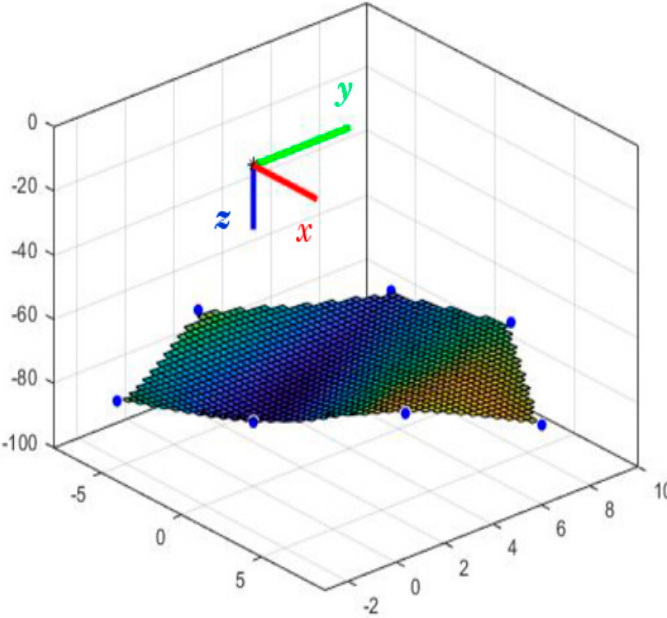
Figure 11. Positions of the end of the fi rst segment. Source: authors.